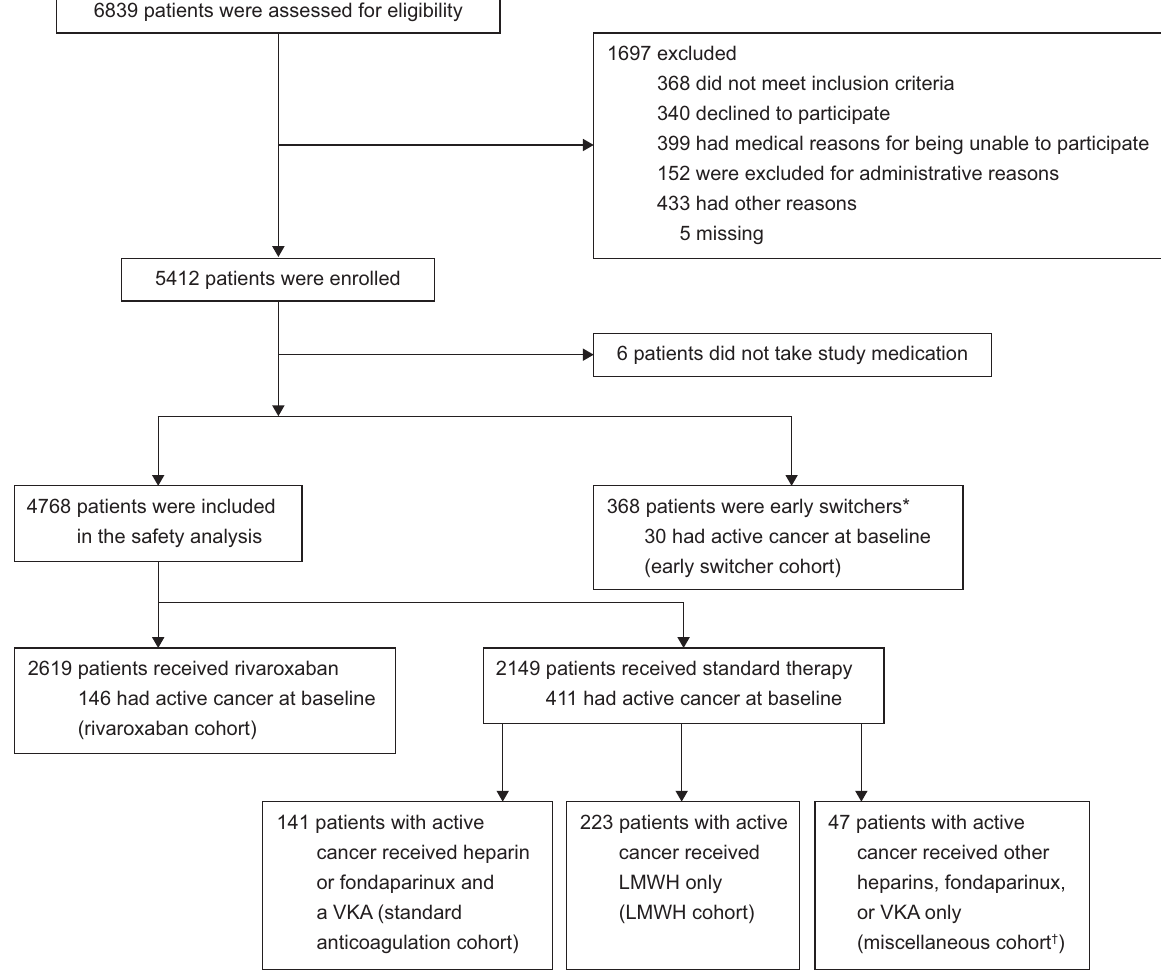
Fig. 1 Flow of patients through the study. A total of 5,142 patients were enrolled in XALIA; 6 patients were excluded as they did not take study medication. Of the remaining 5,136 patients, 587 (11.4%) had known or newly diagnosed cancer at baseline. Patients with cancer were administered various anticoagulant treatment regimens, with the LMWH-treated patients comprising the largest of the fi ve study cohorts. (cid:4) Early switchers were those patients treated with rivaroxaban who received heparin or fondaparinux for > 48 hours to 14 days or a VKA for 1 – 14 days before changing to rivaroxaban. † Miscellaneous cohort included patients treated with other heparins, fondaparinux alone, or a VKA alone. LMWH, low-molecular-weight heparin; VKA, vitamin K